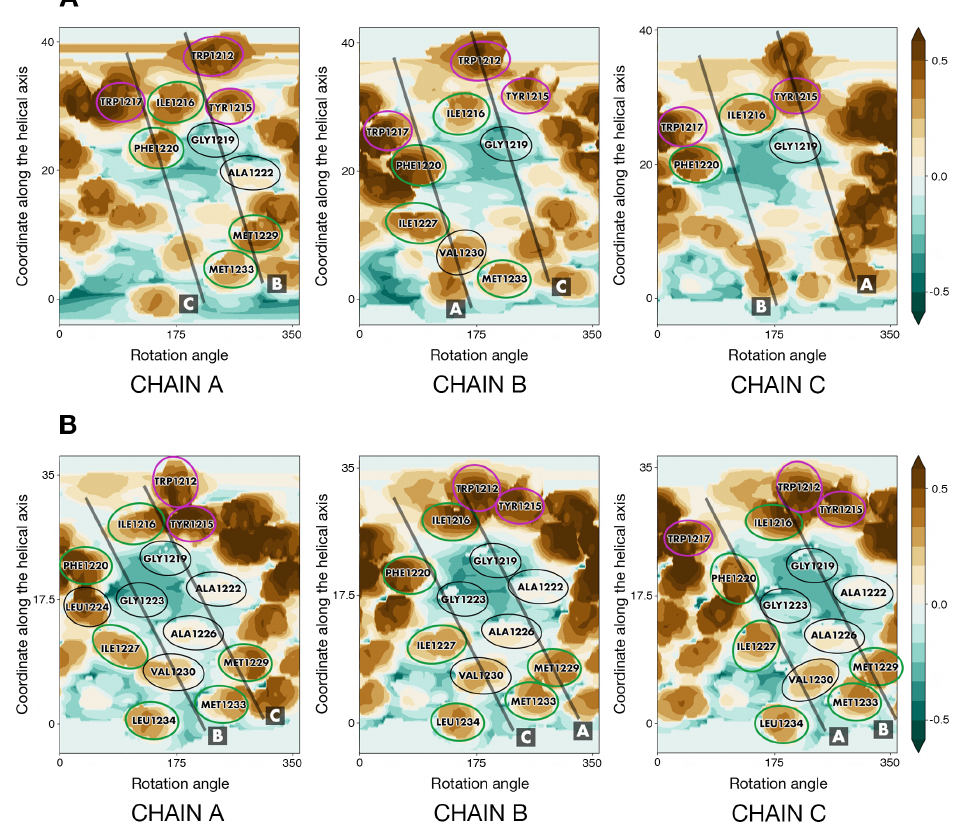
Figure 4. Helix–helix interfaces in S _ TNFR1 and S _ OPT . ( A ) Helix–helix interfaces in S _ TNFR1 before simulation. ( B ) Helix–helix interfaces in S _ OPT upon building and energy minimization. Identical positions are encircled in purple, conservative and semi-conservative residues are encircled in green, and non-conservative residues present on the helix–helix interface are encircled in black. For each chain, projections of the other two helices are shown as semi-transparent black lines and designated by letters A to C. For other details, see the legend in Figure